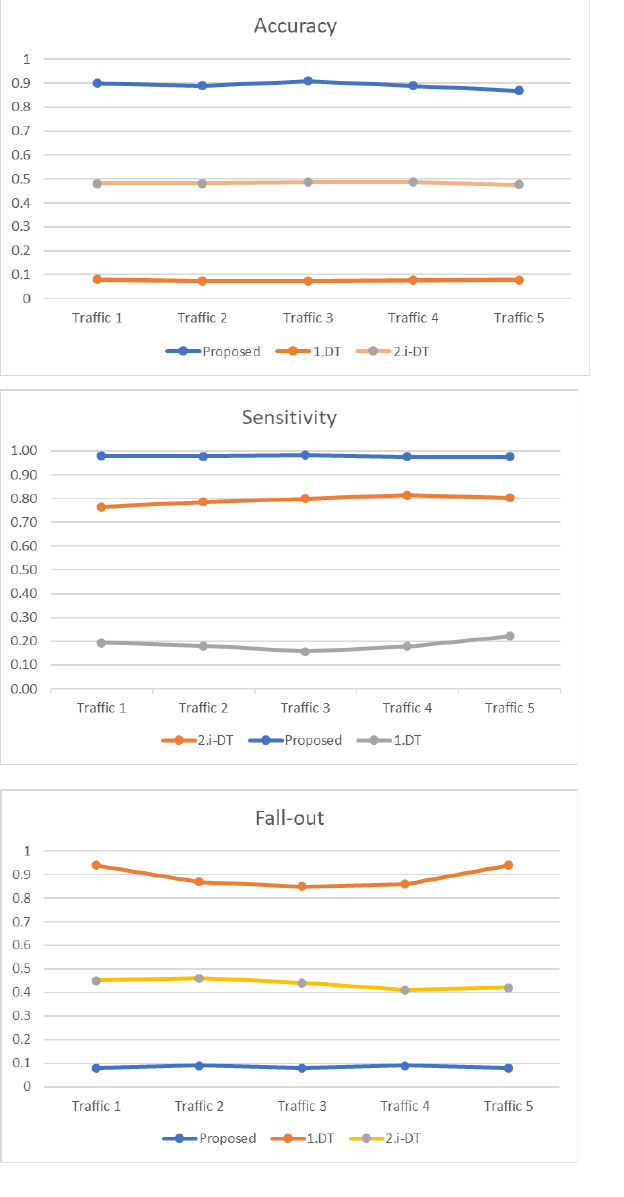
Figure 13. Proposed model detection rate compared to that of the existing